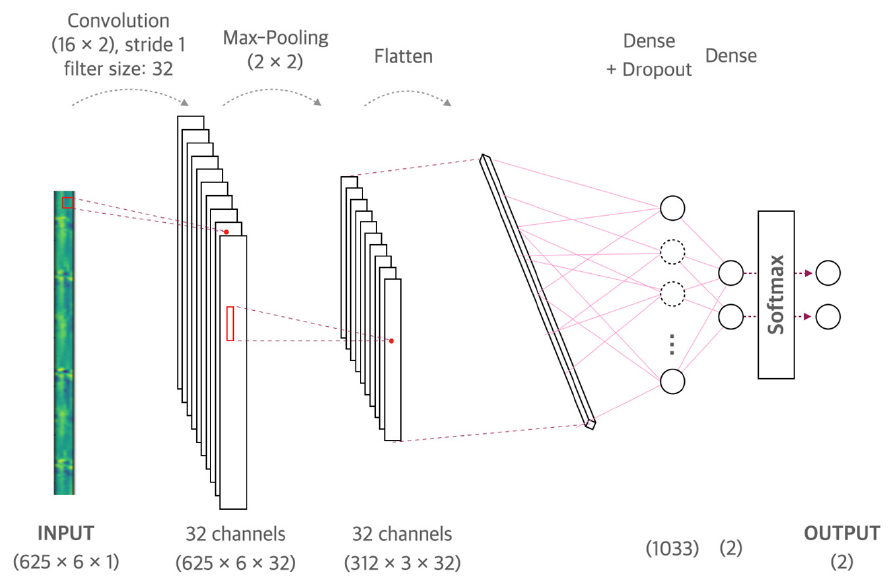
Figure 4. Model based on a convolutional neural network for gait classification.